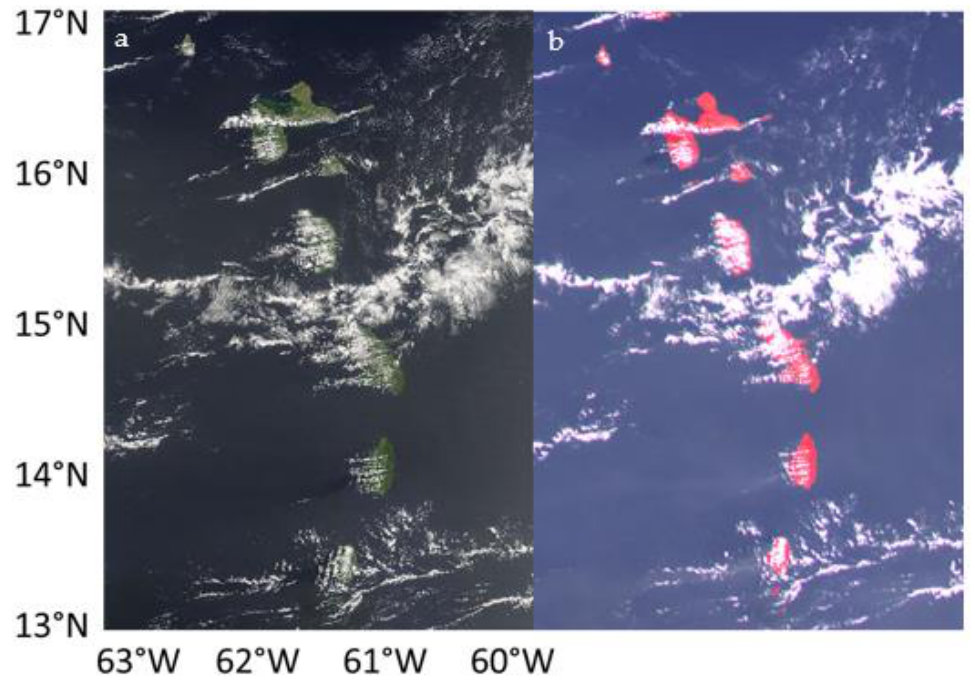
Figure 2. ( a ) Example of color composite from Moderate Resolution Imaging Spectroradiometer (MODIS) (RGB) (left panel) and ( b ) GOES (Near Infra-Red (NIR)-G-B) (right panel) acquired on 8 August 2018 at 14:35 and 14:30 UTC respectively i.e., ca. 10:30 local solar time. The Advanced Baseline Imager (ABI) is the primary instrument on the GOES-R Series for imaging Earth’s weather, oceans, and environment. GOES-ABI is a multi-channel passive imaging radiometer designed to observe the western hemisphere and provides rele-